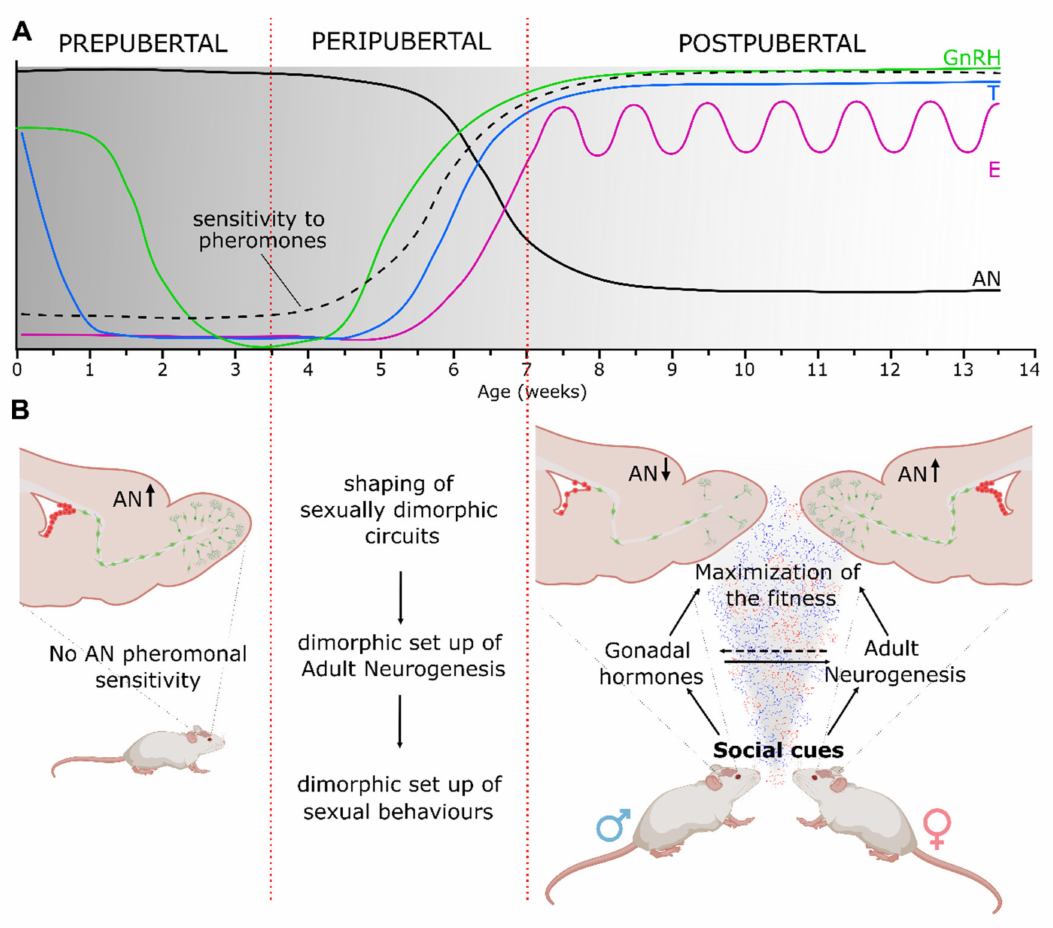
Figure 1. Sex hormones and adult neurogenesis in the mouse brain. In ( A ) is represented the brain sensitivity to sex hormones and pheromones and the time course of endogenous secretions and adult neurogenesis from prepubertal to postpubertal life. According to the “two-stage model” proposed in Schulz and Sisk (2016), the gray to white nuance in the picture illustrates the progressive postnatal reduction of structural brain sensitivity to sex steroids, which peaks during the early prepubertal life (0–3.5 weeks) and peripuberty (3.5–7 weeks), in coincidence with GnRH, testosterone and estradiol release (solid-colored lines). The onset of puberty is triggered by GnRH increase secretion, which results in a rise of circulating sex steroids. In the peripubertal period, adult neurogenesis (solid black line) halves, coinciding with the increase in sex steroids, and in females starts to be modulated by male pheromones (dotted black line). In ( B ) is depicted a representation of adult neurogenesis in the SVZ/OB region during postnatal life and its pheromonal-dependent modulation in females. In the prepubertal period, the level of AN is elevated (green and red cells) and it does not change upon exposure to opposite-sex pheromones. Starting from the late peripubertal period male pheromones stimulate AN and secretion of gonadal hormones, which reciprocally interact to optimize reproduction. Note that peripubertal life is regarded as an important phase of structural and functional hormone-dependent refinement of sexually dimorphic circuits, which includes a set-up of adult neurogenesis in both male and female mice. Abbreviations: AN, adult neurogenesis; E, estradiol; GnRH, gonadotropin-releasing hormones; T, testosterone; SVZ/OB, subventricular zone/olfactory